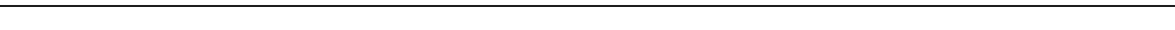
Fig. 6 Loss of GCNT2 enhances IGF-1-induced PI3K and ECM-induced MAPK signaling pathways. a Schematic of IGF1R:IGF-1-induced melanoma signaling. Cells were treated with 100 ng/ml rhIGF-1 and lysed in RIPA buffer. b , c Immunoblot ( b ) and quantitation ( c ) of phosphorylated and total IGF1R and AKT in UACC62 scrambled control and GCNT2 KD (left) cell variants and A375 vector control and GCNT2 OE (right) cell variants treated with rhIGF-1 for 15 or 60 min. Quantitation of phosphorylated proteins was normalized to total protein expression and then compared to control cells. d Schematic of integrin: ECM-induced melanoma signaling. Cells were plated on an ECM mixture composed of fi bronectin, laminin, and collagen I, and lysed in RIPA buffer. e , f Immunoblot ( e ) and quantitation ( f ) of tyrosine phosphorylation and total actin, phosphorylated and total focal adhesion kinase (FAK) and phosphorylated and total ERK1/2 in UACC62 scrambled control and GCNT2 KD (left) cell variants and A375 vector control and GCNT2 OE (right) cell variants plated on ECM for 60 min. g Schematic representation of kifunensine treatment. h , i Immunoblot ( h ) and quantitation ( i ) of phosphorylated and total IGF1R and AKT in kifunensine treated UACC62 scrambled control and GCNT2 KD (left) cell variants and A375 vector control and GCNT2 OE (right) cell variants treated with rhIGF-1 for 15 or 60 min. j , k Immunoblot ( j ) and quantitation ( k ) of cell tyrosine phosphorylation and total actin, phosphorylated and total focal adhesion kinase (FAK) and phosphorylated and total ERK1/2 in kifunensine treated UACC62 scrambled control and GCNT2 KD (left) cell variants and A375 vector control and GCNT2 OE (right) cell variants plated on ECM for 60 min. Quantitation of phosphorylated proteins was normalized to total protein expression and then compared to control cells. Statistical analyses were done using one-way ANOVA with Dunnett ’ s multiple comparisons test. Results are representative of n = 3 experiments (mean ± SEM; ** p < 0.01; *** p < 0.001). See also Supplementary Fig.